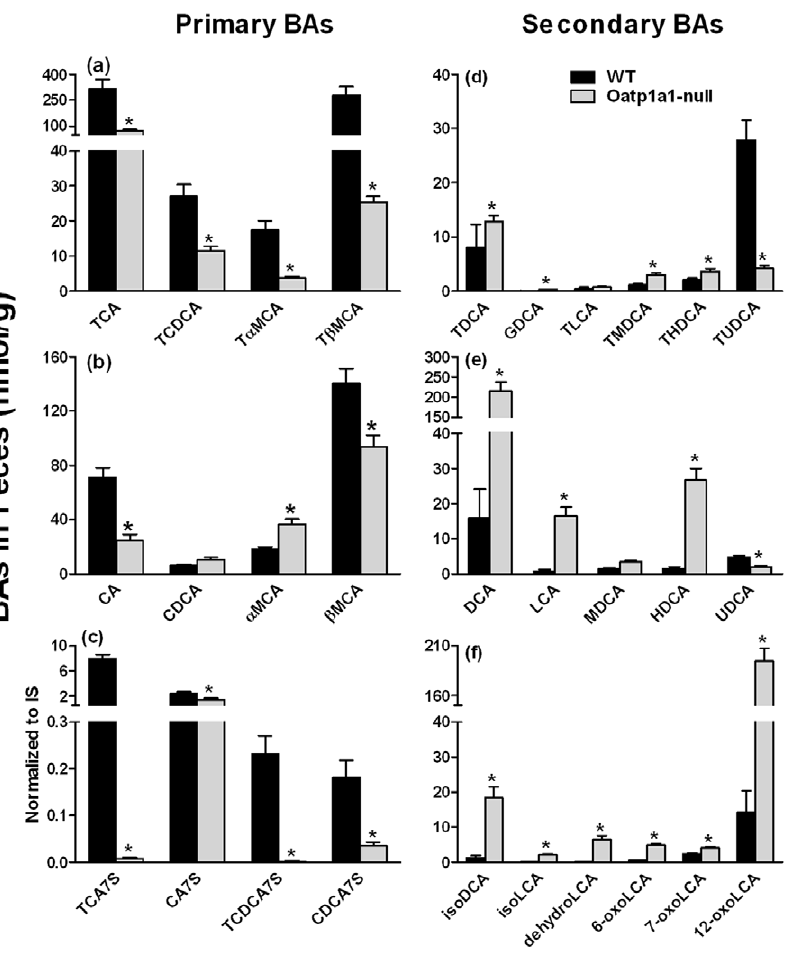
Figure 2. Concentrations of primary and secondary BAs in the feces of WT and Oatp1a1-null mice. Feces were collected from WT and Oatp1a1-null mice for 24 hr and dried under vacuum. The concentrations of primary BAs (a, b, and c) and secondary BAs (d, e, and f) in the feces of male WT and Oatp1a1-null mice (n=5/group) were analyzed using ultra performance liquid chromatography-tandem mass spectrometry (UPLC-MS/ MS) and normalized by fecal dry weight. All data are expressed as mean 6 S.E. of five mice in each group. *, statistically significant difference between WT and Oatp1a1-null mice ( p , 0.05).